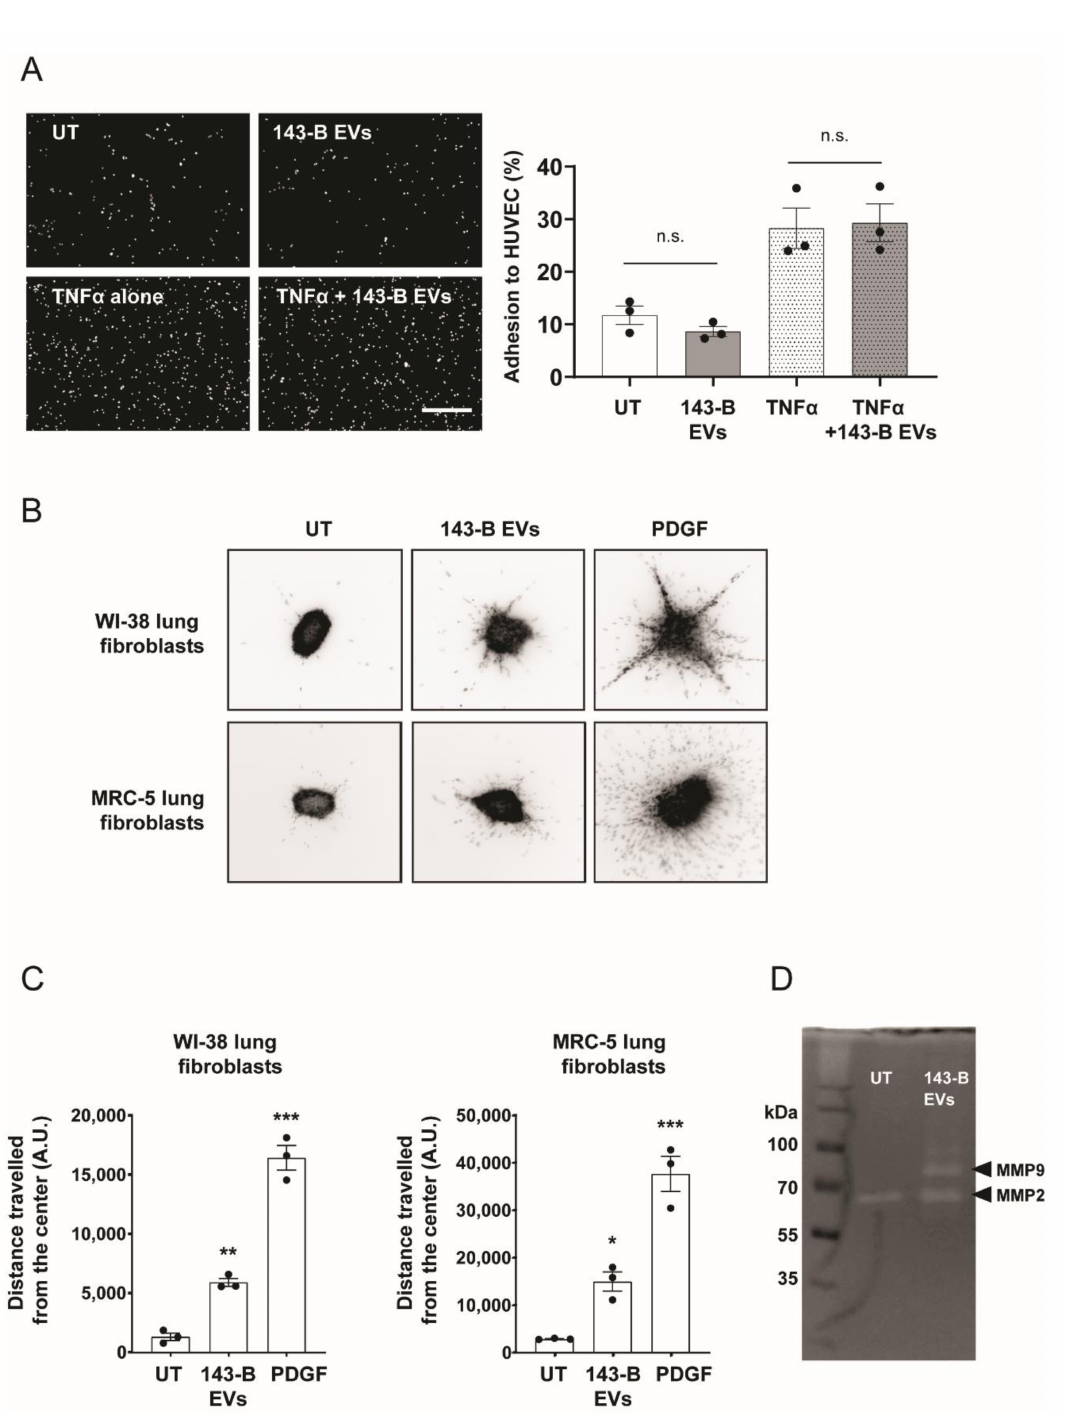
Figure 2. Functional consequences of 143-B EV treatment of endothelial cells and lung